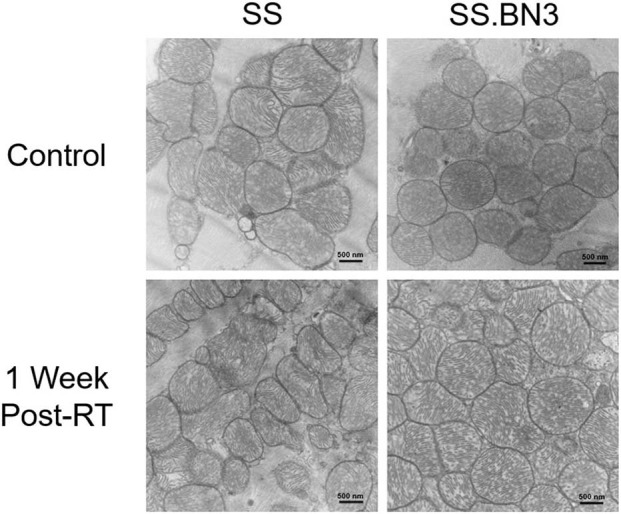
Representative TEM images revealed SS and SS.BN3 have no observed changes in mitochondrial morphology at 1 week post-radiation therapy (RT). Transmission electron microscopy (TEM) was performed on SS and SS.BN3 rat left ventricle tissue harvested 1 week after either 24 Gy RT or mock treatment (N = 2–5/group). No gross changes in mitochondria were seen between groups. Representative images from each condition are shown. Scale bar = 500 nm.